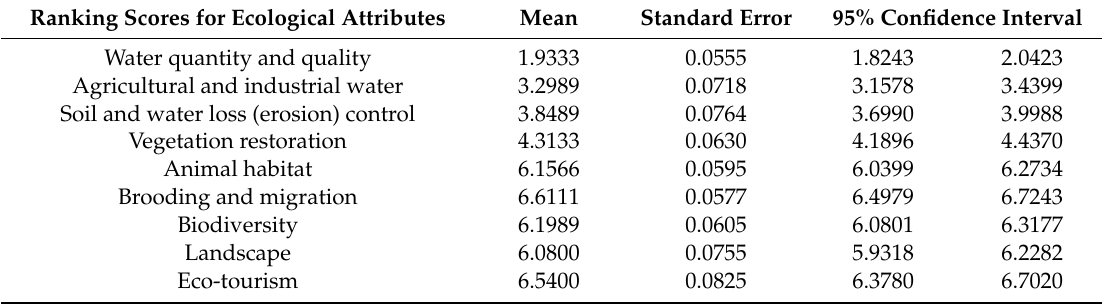
Table 4. Mean and standard errors for the rankings of ecological